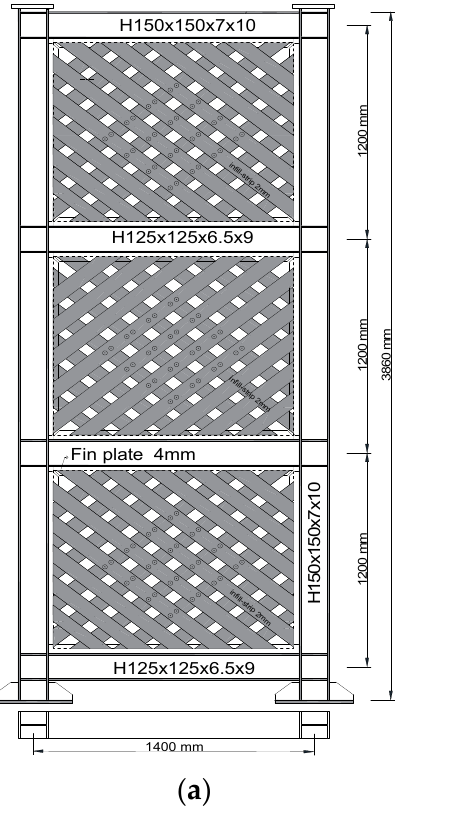
Figure 2. ( a ) IWS-SPSW test specimen ( b ) Infill web strip layout. Unit (mm). Figures 1c and 2 represent the details of the IWS- SPSW and USPSW test speci- mens with rigid beam-to-column connections. Full-penetration groove welds connect the beam webs and flanges to the column flanges in the moment-resistant connection. In the IWS-SPSW test specimens, the infill web strips were placed on the opposite sides of the beam and column fin plates in right-leaning and left-leaning orientations,